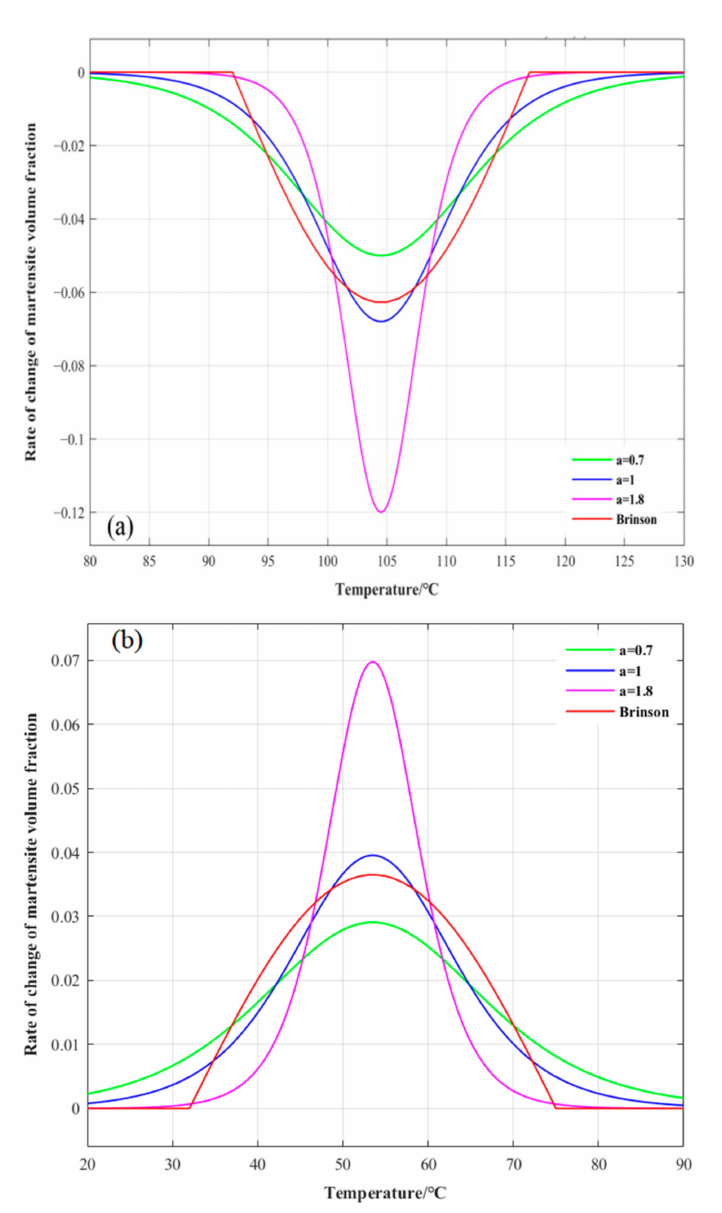
Figure 3. Relationship between the rate of change of the martensite volume fraction and the tempera- ture for different transformation rate coefficients: ( a ) reverse martensitic transformation, ( b ) marten- sitic